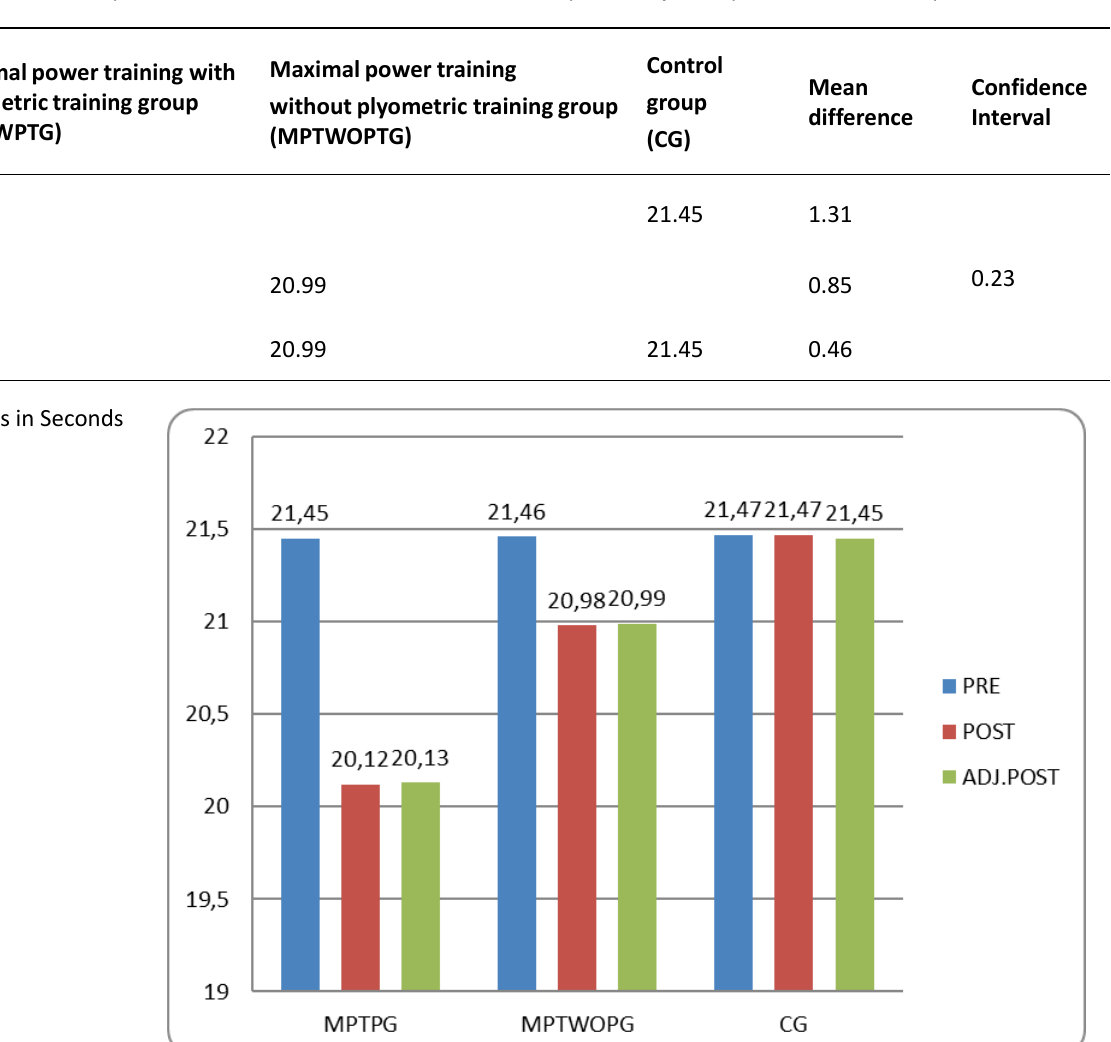
Figure 1. Speed Table 4. Analysis of covariance on pre, post and adjusted post test means on upper body power height of maximal